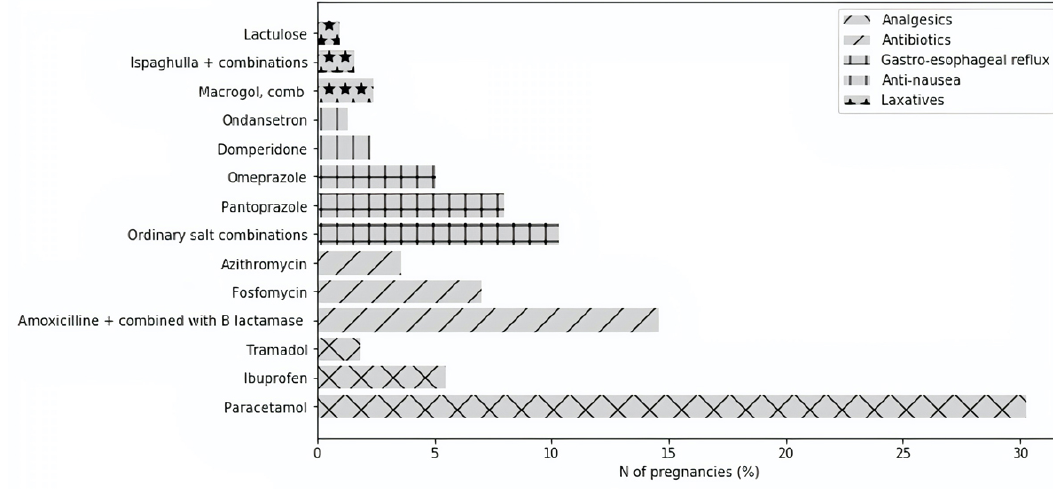
Table 2: Exposure to potentially teratogenic or fetotoxic drugs during risk period and associated potential risks (extrapolated numbers). Potentially teratogenic or feto- toxic drugs (ATC